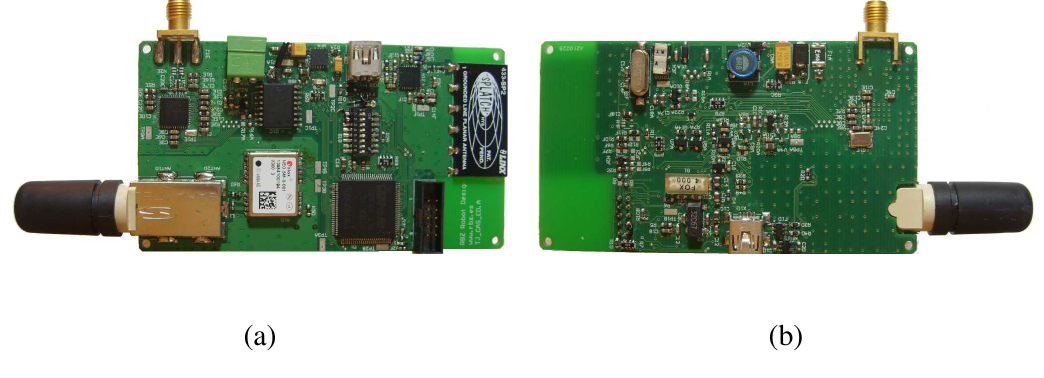
Figure 6. (a) Top and (b) bottom view of the primary node.